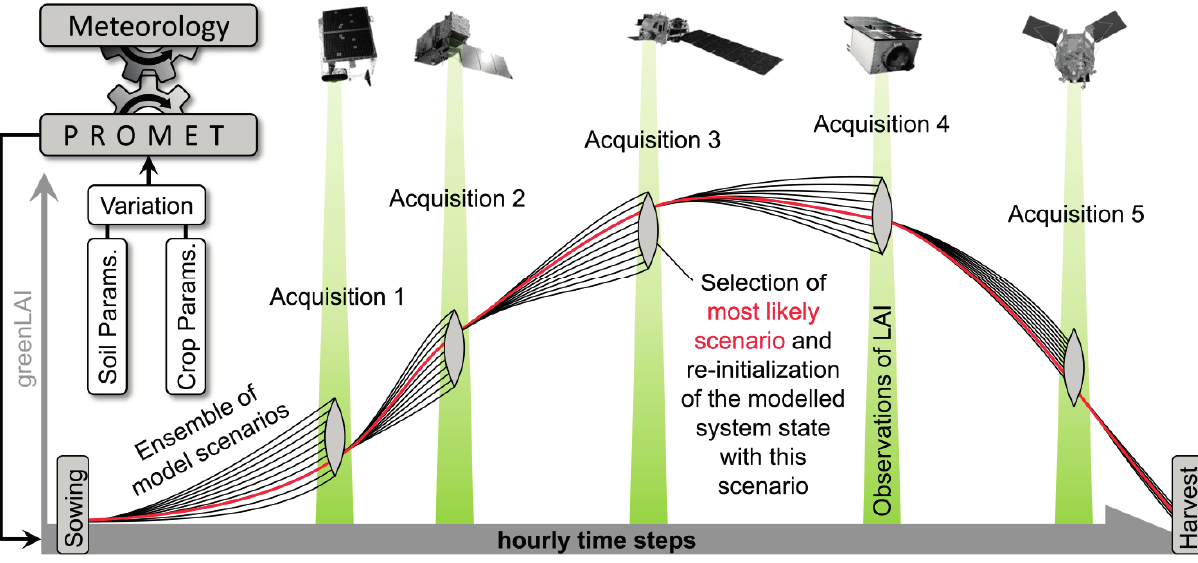
Figure 3. Concept of using the distributed crop growth model PROMET for the generation of model ensembles and selecting the most likely scenario for each pixel by comparing modelled greenLAI with greenLAI values retrieved from remote sensing. The concept is designed for multi-sensoral use. The number of selections during the growing season depends on the number of available